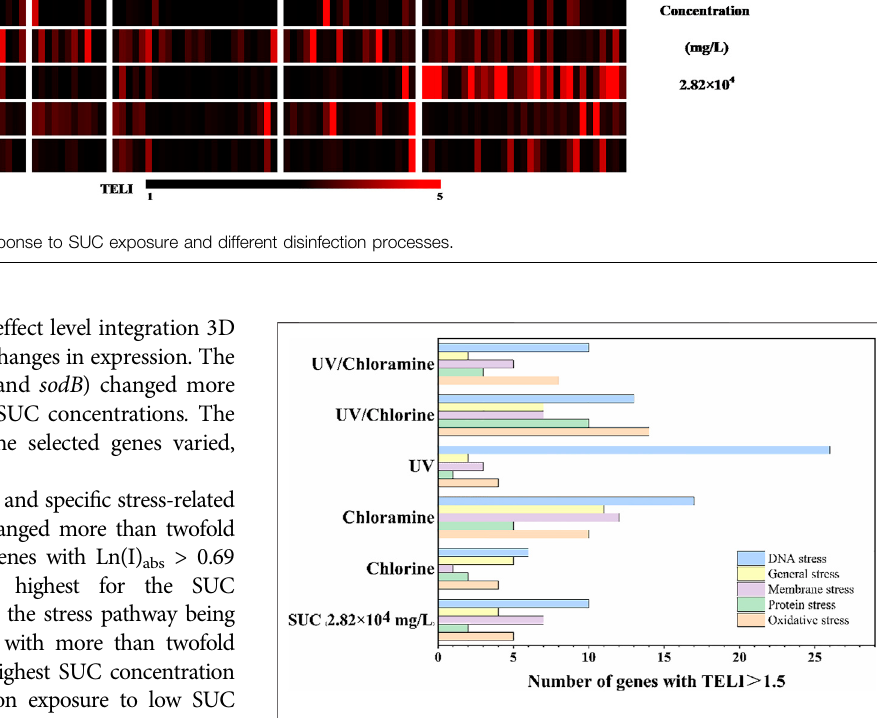
FIGURE 12 | Number of genes with TELI > 1.5 under different disinfection